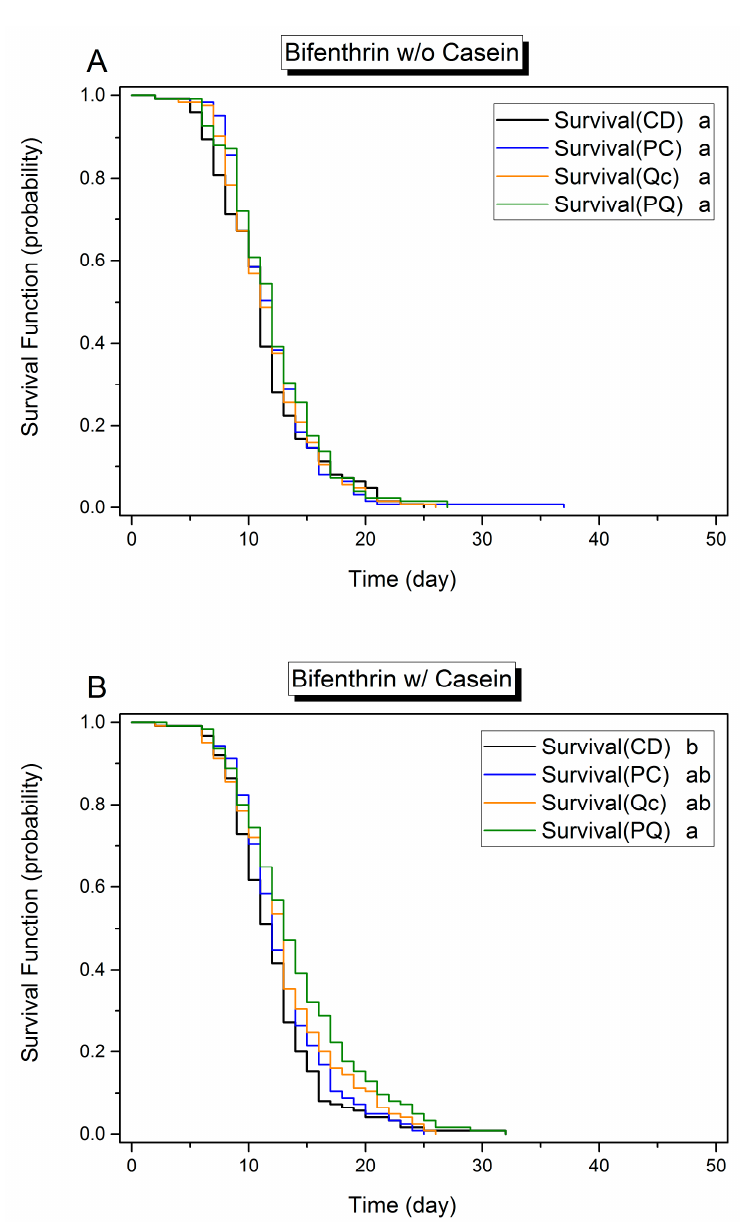
Figure 2. Kaplan–Meier plot of honey bee survival function on different diets with different phytochemical supplements and bifenthrin amendment. Theses diets were ( A ) protein-free or ( B ) protein-supplemented. CD, diet lacking phytochemicals; PC, diet containing 0.5 mM p- coumaric acid; Qc, diet containing 0.25 mM quercetin; PQ, diet containing 0.5 mM p- coumaric acid and 0.25 mM quercetin. ( n = 125 for each group.) Different lower-case letters indicate statistical differences between treatments (log-rank paired test, p < 0.0083 after Bonferroni correction).